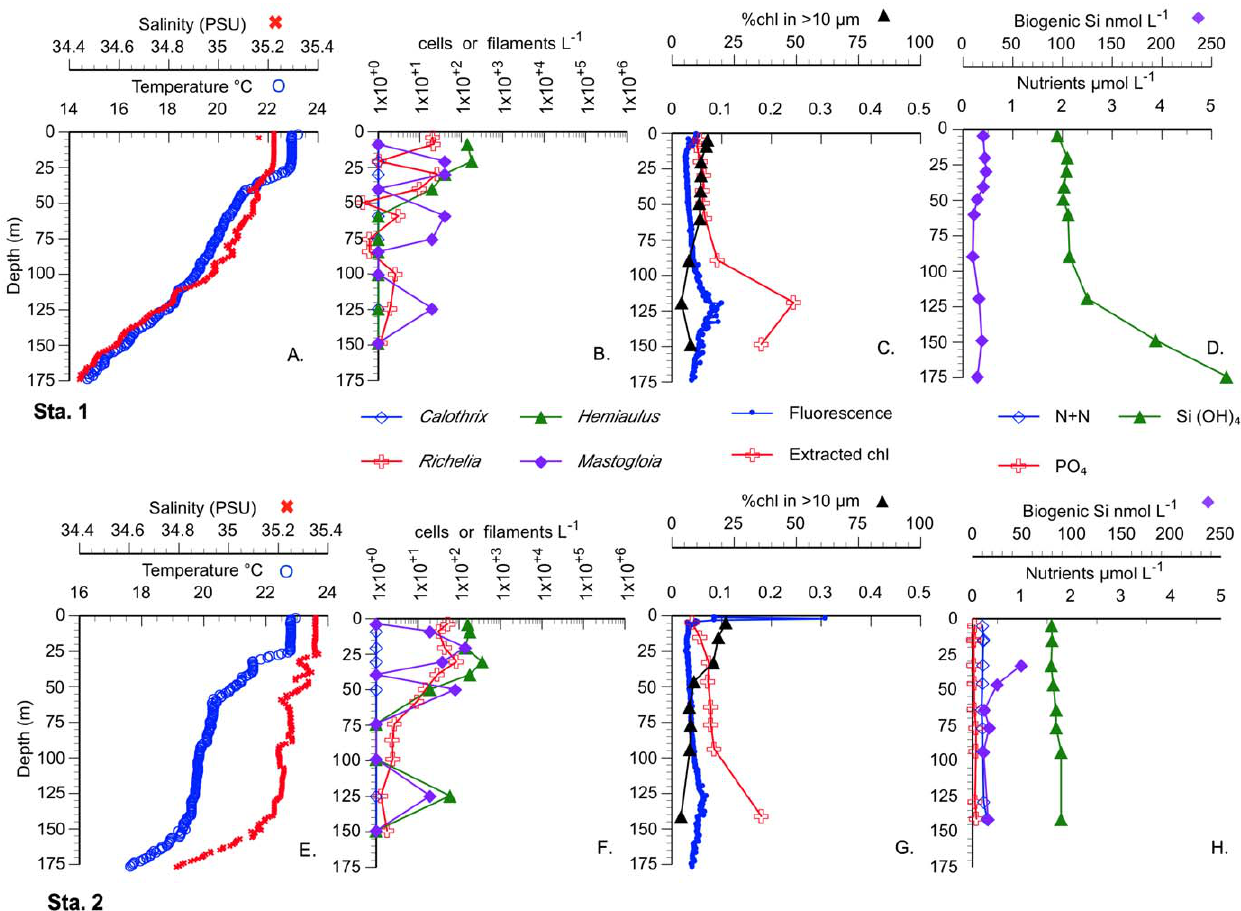
Figure 3. Vertical profiles of Sta. 1 and 2 (outside the bloom area) in 2008. A-D Station 1, E-H Sta. 2. A, E. Temperature and Salinity CTD profiles. B, F. Cell and symbiont abundance. C., G. Chl a . (CTD fluorescence, extracted and % . 10 m m). D., H. Silicate and biogenic silica concentrations.